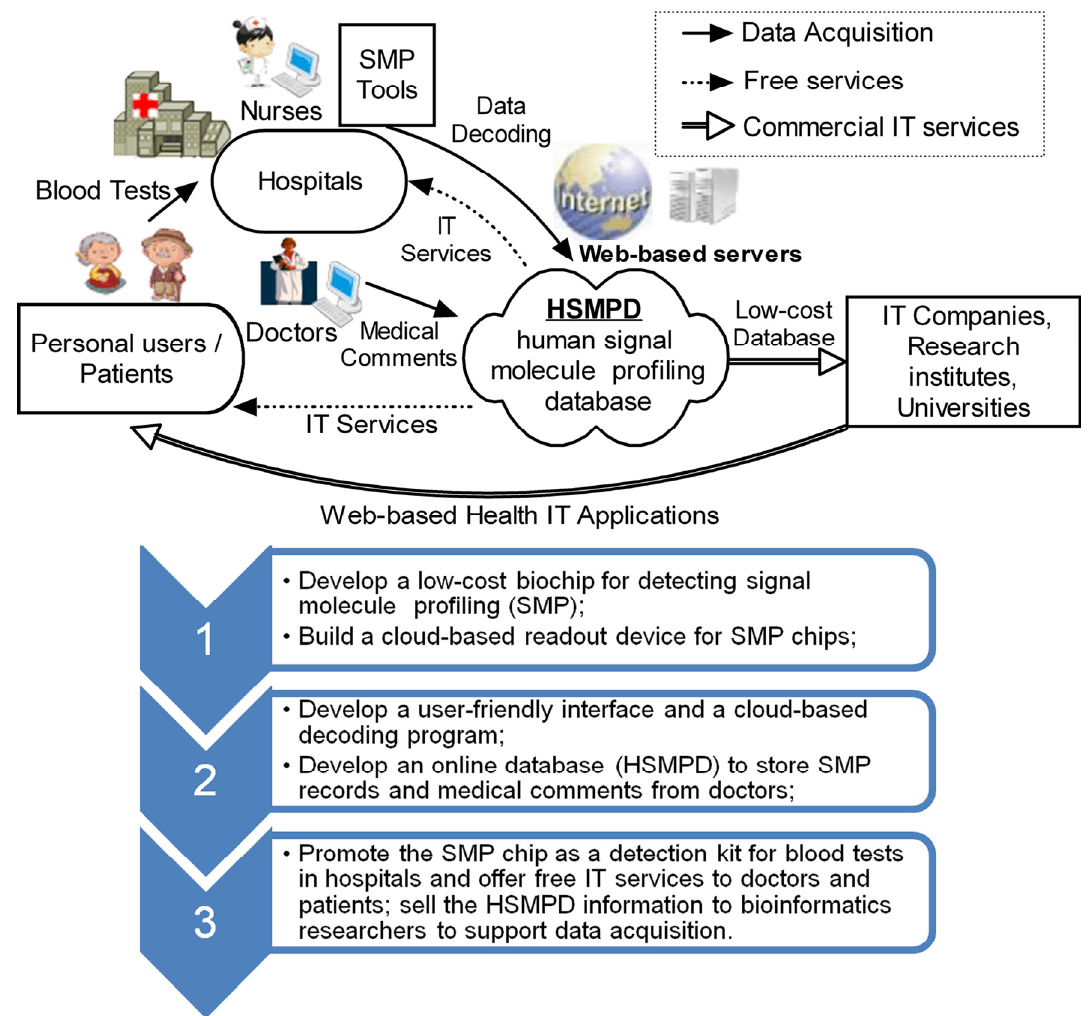
Figure 2. Technology roadmap of HSMPD construction. HSMPD is a bridge to connect traditional health care systems with the TBI community. The HSMPD services on TBI community can provide a stable income to support the data acquisition process of HSMPD, which forms a self-motivated